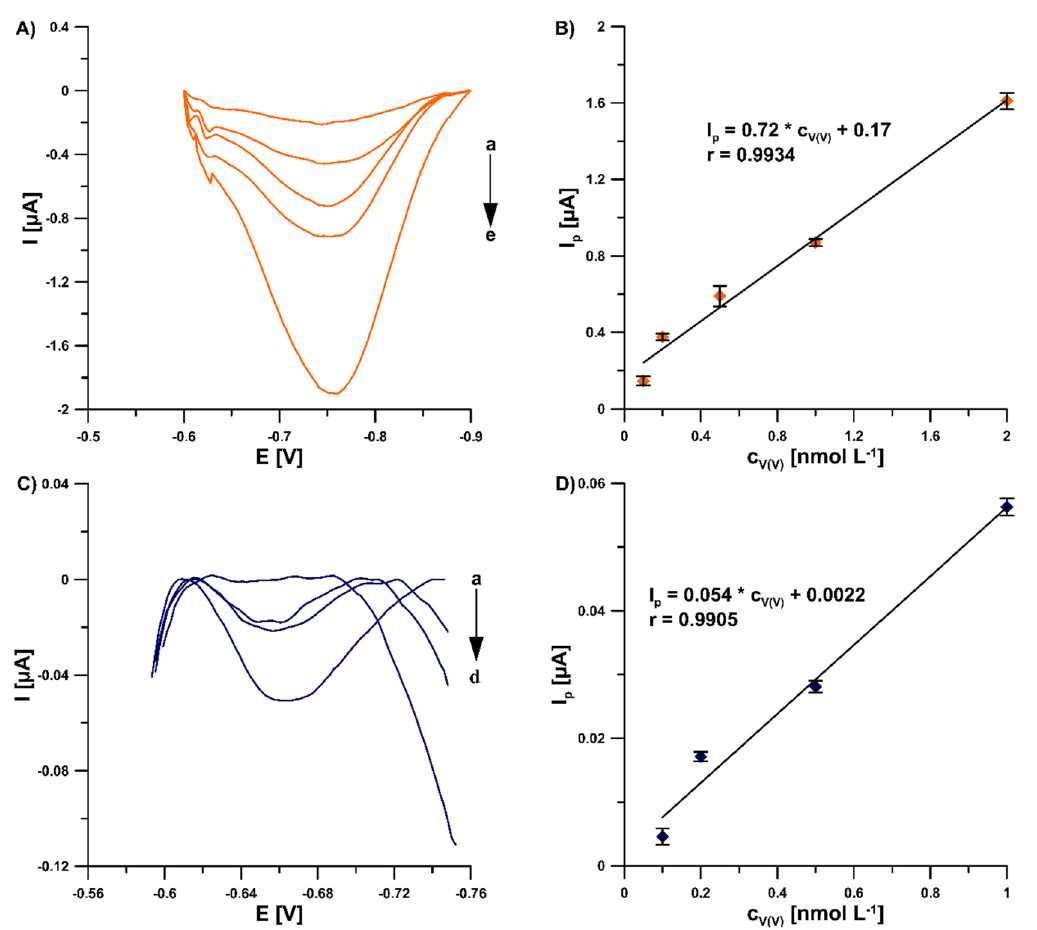
Figure 2. DPAdSV curves registered at the GCE/PbF in 0.3 mol L − 1 buffer solution (CH 3 COONH 4 , CH 3 COOH, and NH 4 Cl) of pH 5.6 ± 0.1 in the presence of 3.0 × 10 − 4 mol L − 1 Pb(NO 3 ) 2 , increasing concentration of V(V) (a: 1.0 × 10 − 10 , b: 2.0 × 10 − 10 , c: 5.0 × 10 − 10 , d: 1.0 × 10 − 9 , e: 2.0 × 10 − 9 mol L − 1 ) and ( A ) 7.0 × 10 − 4 mol L − 1 cupferron, ( C ) 3.0 × 10 − 5 mol L − 1 chloranilic acid and 1.0 × 10 − 2 mol L − 1 bromate ions. ( B ) V(V) calibration graph in the presence of cupferron as a complexing agent, ( D ) V(V) calibration graph in the presence of chloranilic acid and bromate ions. The parameters: − 1.1 V (E dep. Pb ) for 20 s (t dep. Pb ), − 0.6 V (E acc. ) for 30 s (t acc. ), 100 mV ( Δ E A ), 20 mV s − 1 ( ν ), and 2 ms (t m ). The average values of Ip are presented with the standard deviation of n = 3.